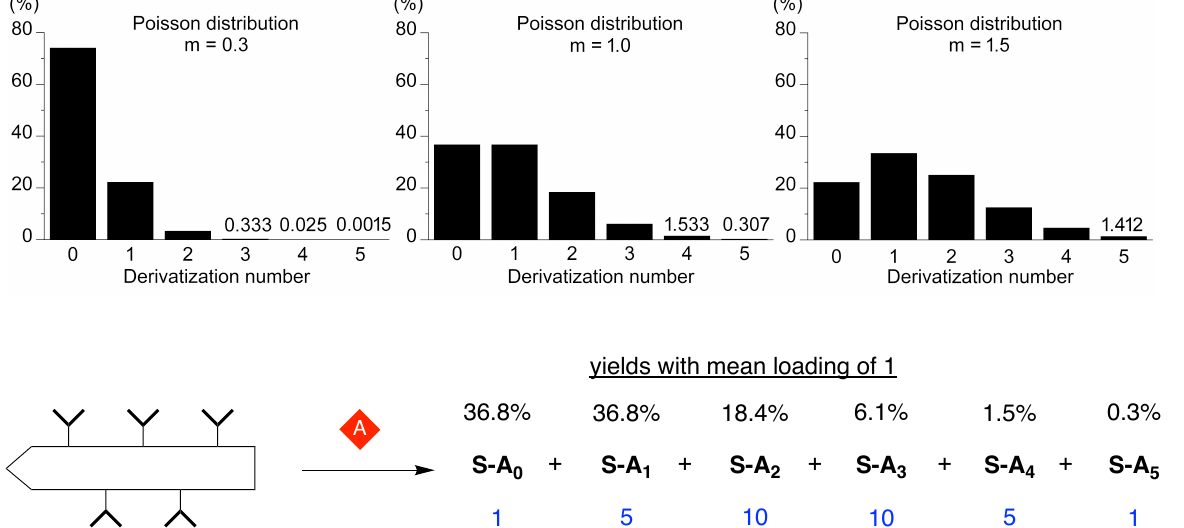
Scaffold ( S ) with five reactive sites